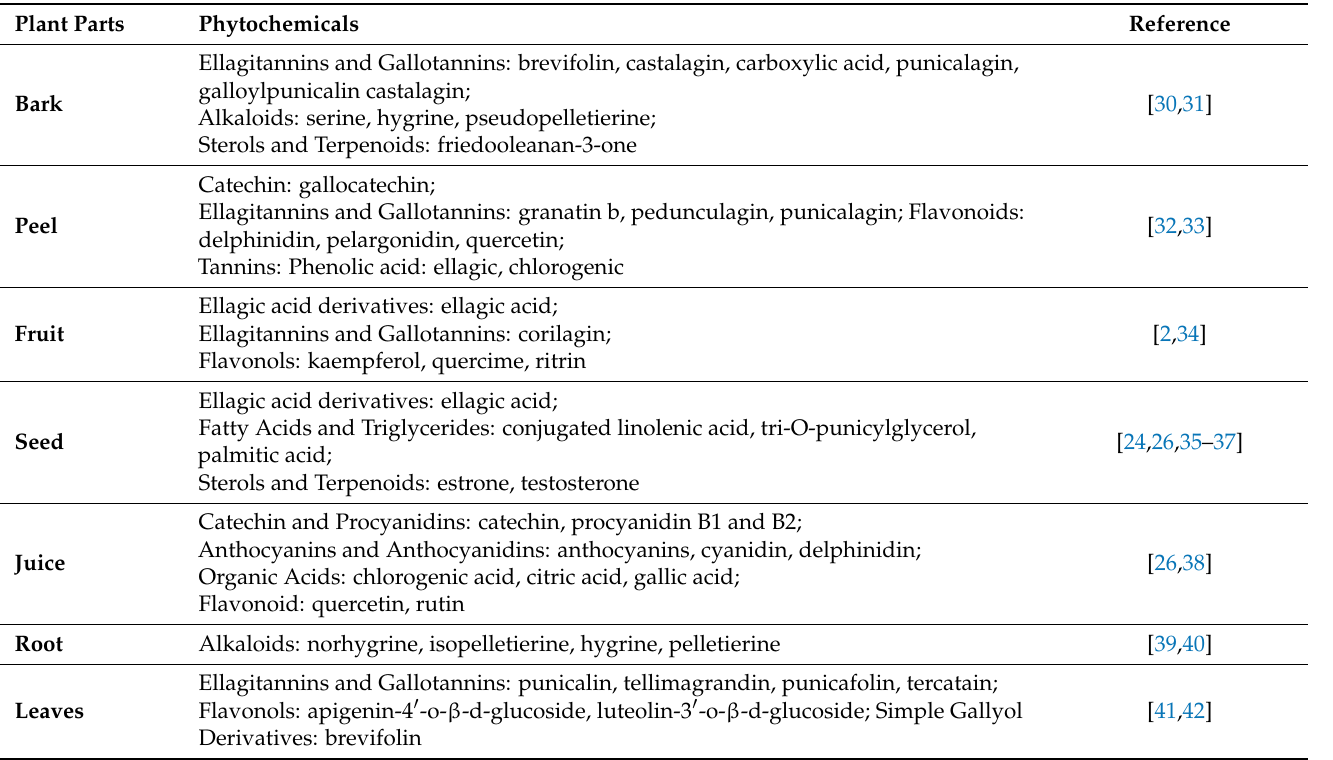
Table 1. Phytochemical components of P. granatum .